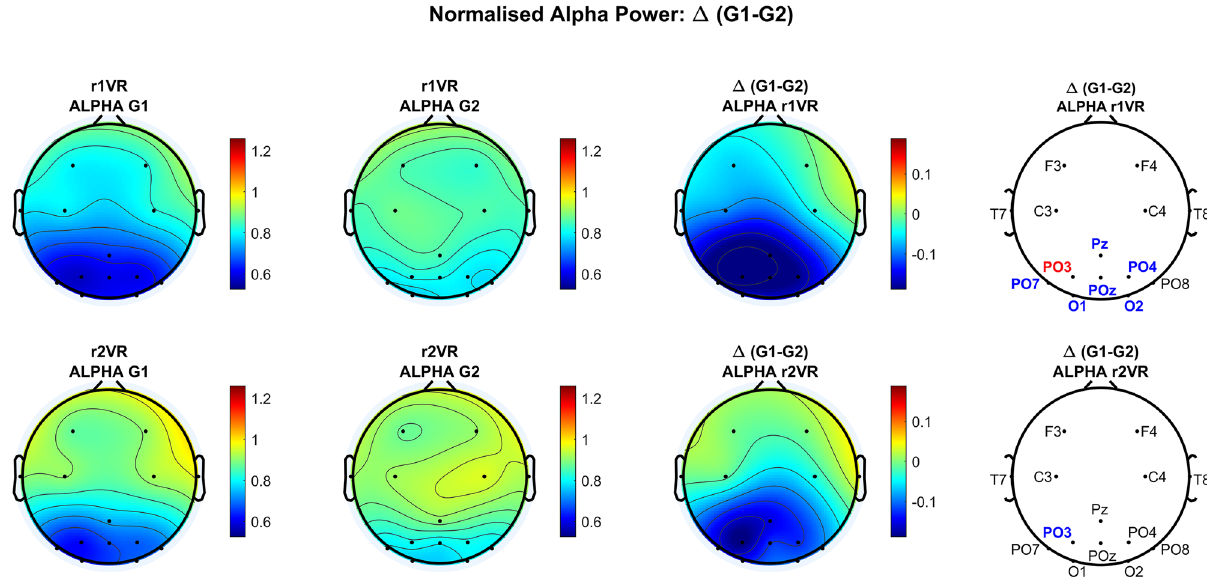
Figure 6. Channel-wise analysis in group G1 and G2: scalp maps and statistical analysis for normalised alpha power. Each row refers to a VR phase: r1VR on the first row and r2VR on the second row. The maps in the first and second column represent the normalised alpha power averaged across participants of group G1 and G2 respectively. The maps in the third column represent the normalised alpha power difference between G1 and G2. In the cartoon heads of the fourth column, the results of the statistical comparison between the two groups (one-tailed permutation-based t test for independent samples) are shown: the blue markers denote the uncorrected statistically significant electrodes (uncorrected p-value < 0.05) while the red markers denote electrodes where significance survived the correction for multiple comparisons (maximal statistics, corrected p-value < 0.05). The only significant difference between groups G1 and G2 after p-values correction was achieved in r1VR phase and for the PO3 electrode (corrected p-value =